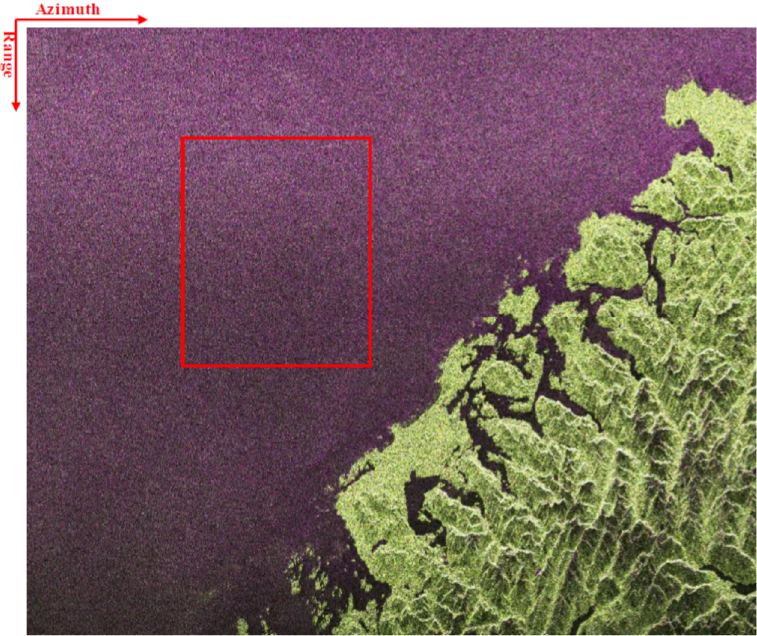
Figure 12. Pseudo-colored RGB image of GF3 ocean data under the high-sea state with R = | HH − HV | , G = | HV | and B = | HH | Table 5. Detailed parameter of the high-sea state data.